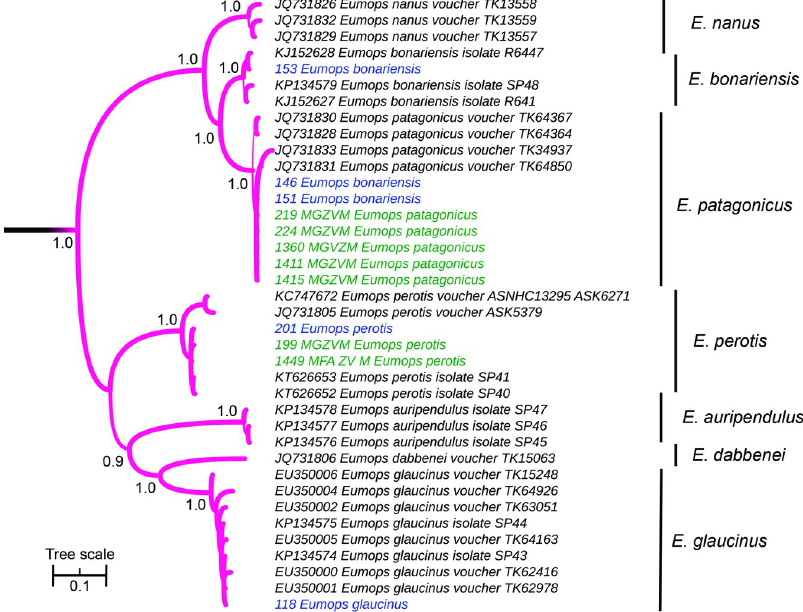
Fig 3. Cytochrome b -based Bayesian phylogeny of Eumops . Main clades posterior probability values are annotated. Branch width represents internal node support. Terminal font color indicates sequence source: black indicates sequences retrieved from Genbank, green indicates museum voucher sequences obtained in this study, while blue color indicates samples captured at the field and sequenced in this study. The scale units are substitutions per site.